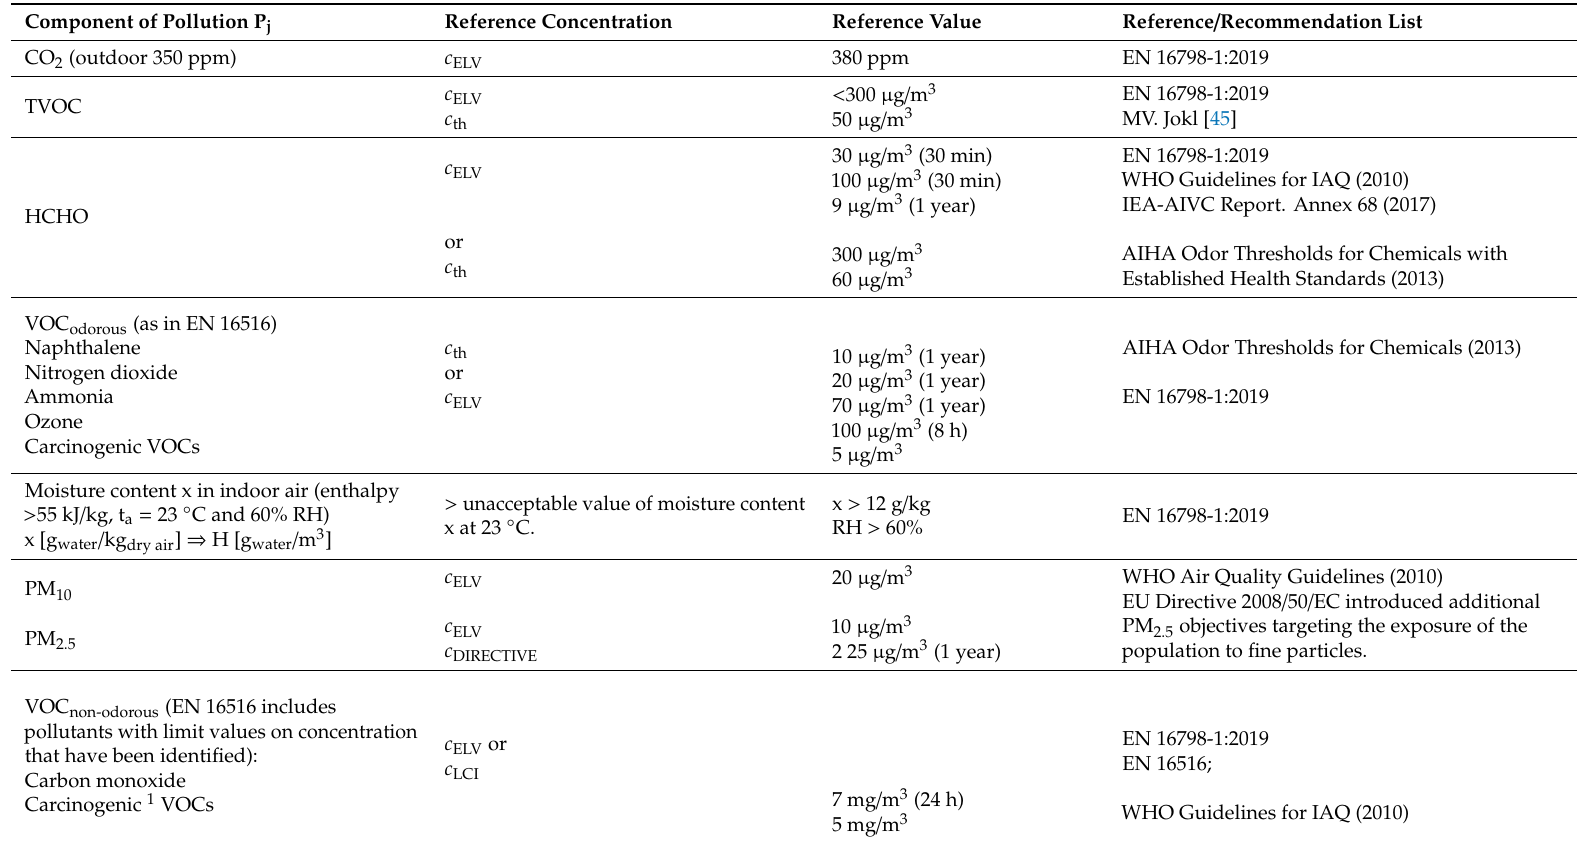
Table 2. Exemplary pollution concentration reference values for low-pollution